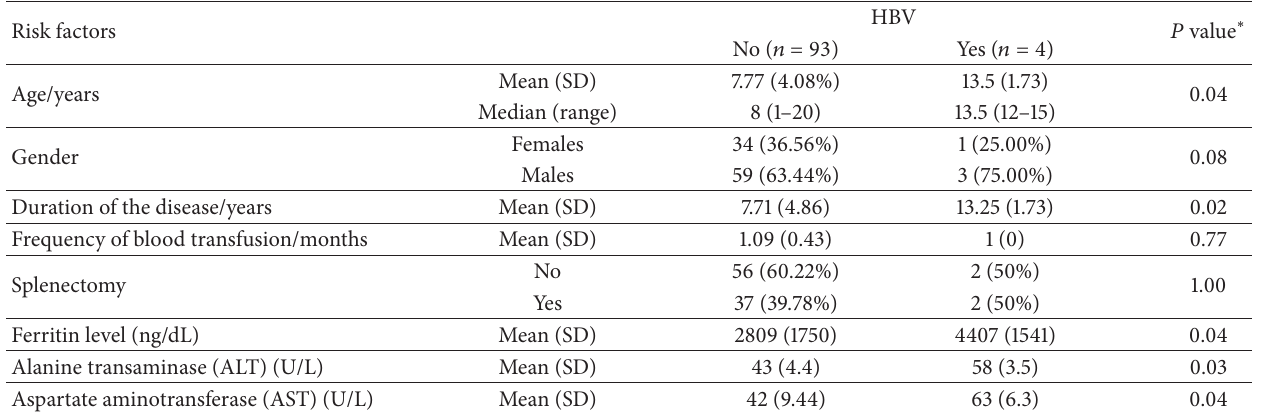
Table 4: Risk factors for